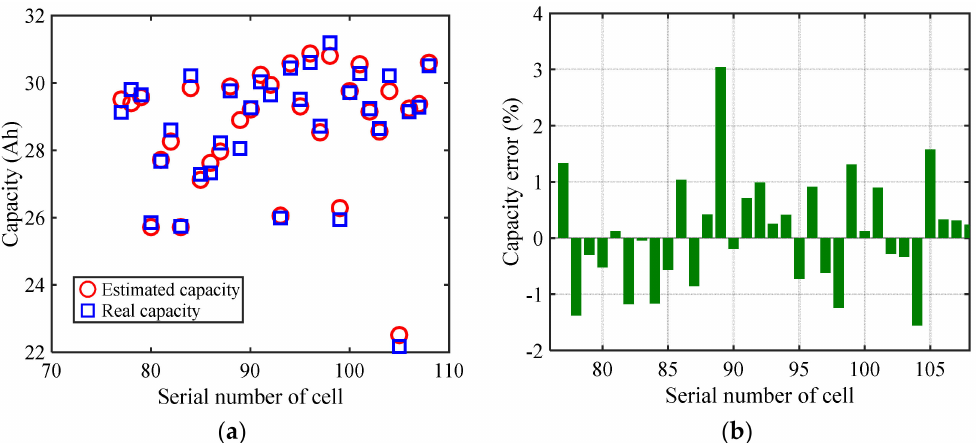
Figure 9. Capacity estimation results: ( a ) Capacity; ( b ) capacity error.